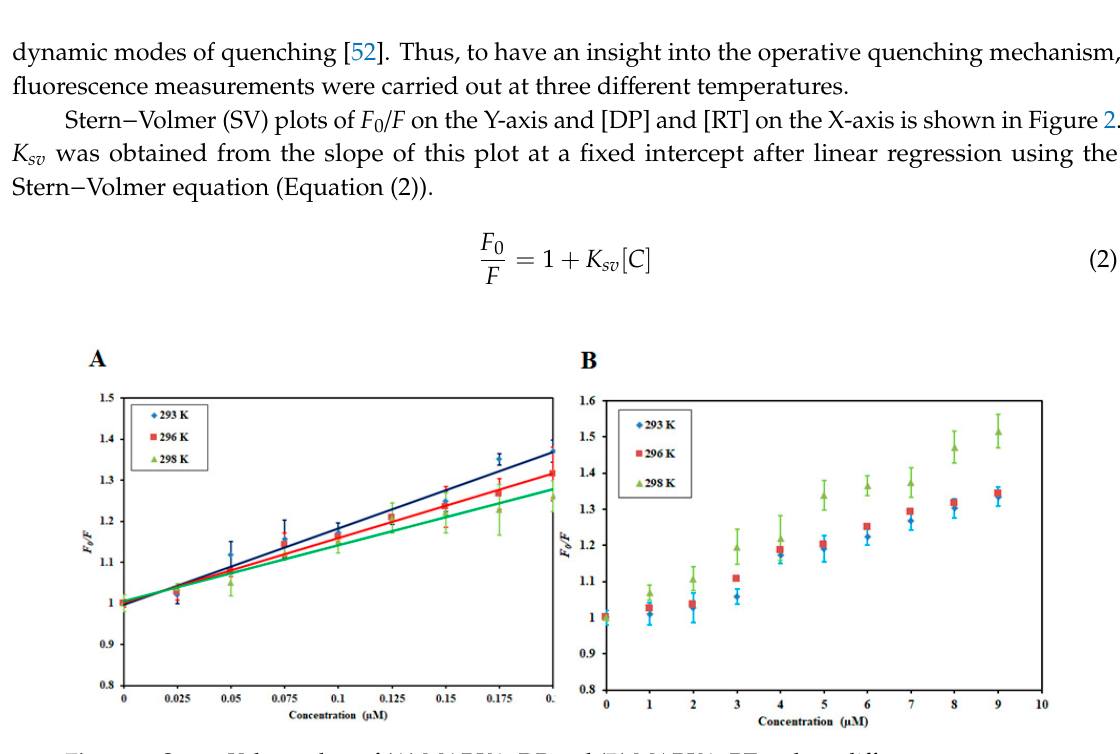
Table 1. Stern − Volmer constants calculated for interactions of MARK4 with DP and RT at different temperatures.